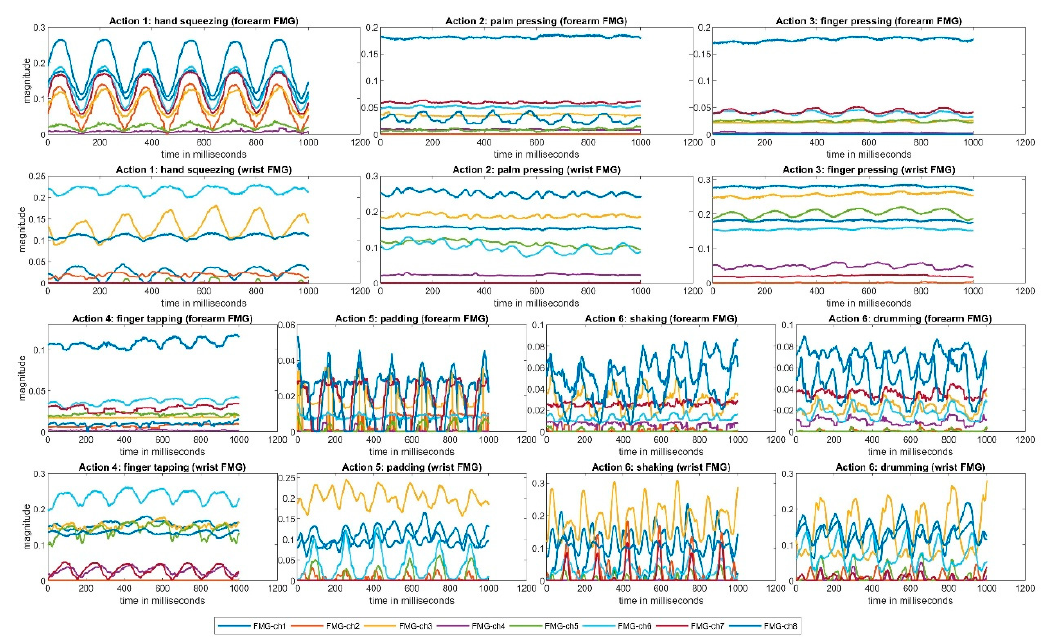
Figure 5. One second of FMG signals collected during one trial.